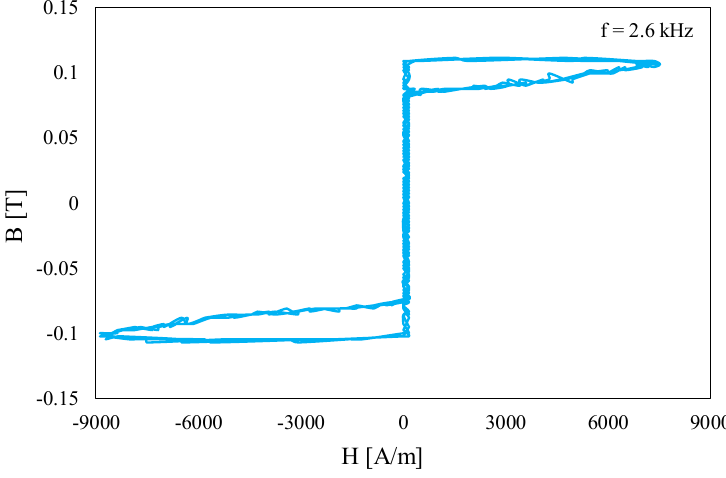
Figure 8. Hysteresis loop of the investigated nanocrystalline core.